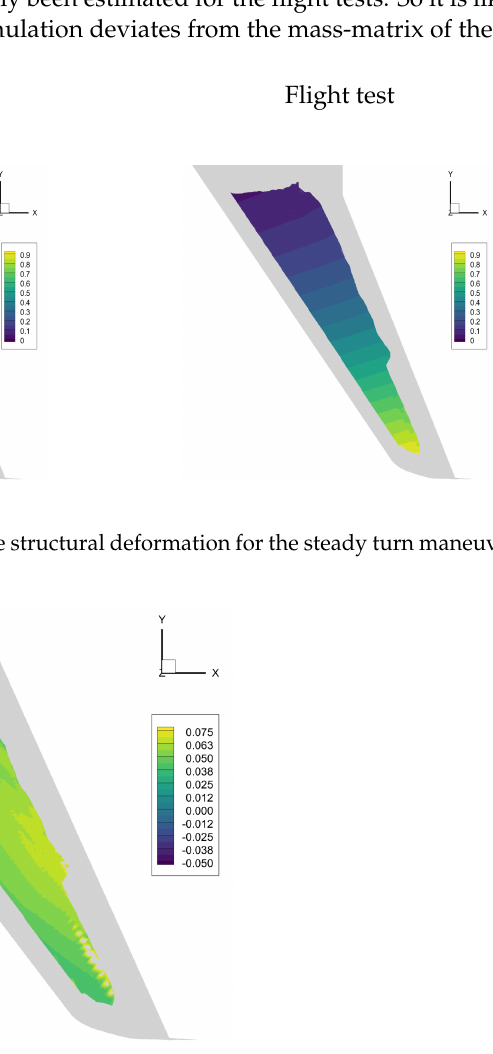
Figure 9. Difference of the deformation magnitude between simulation and experimental results, normed by the simulation